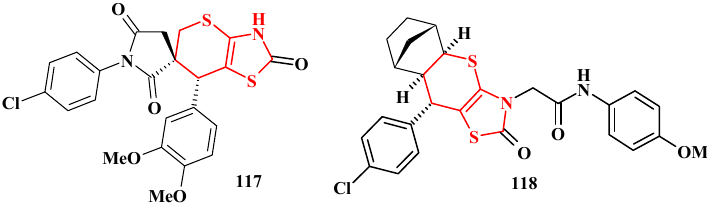
Figure 8. Thiopyrano[2,3- d ]thiazoles with trypanocidal activity.